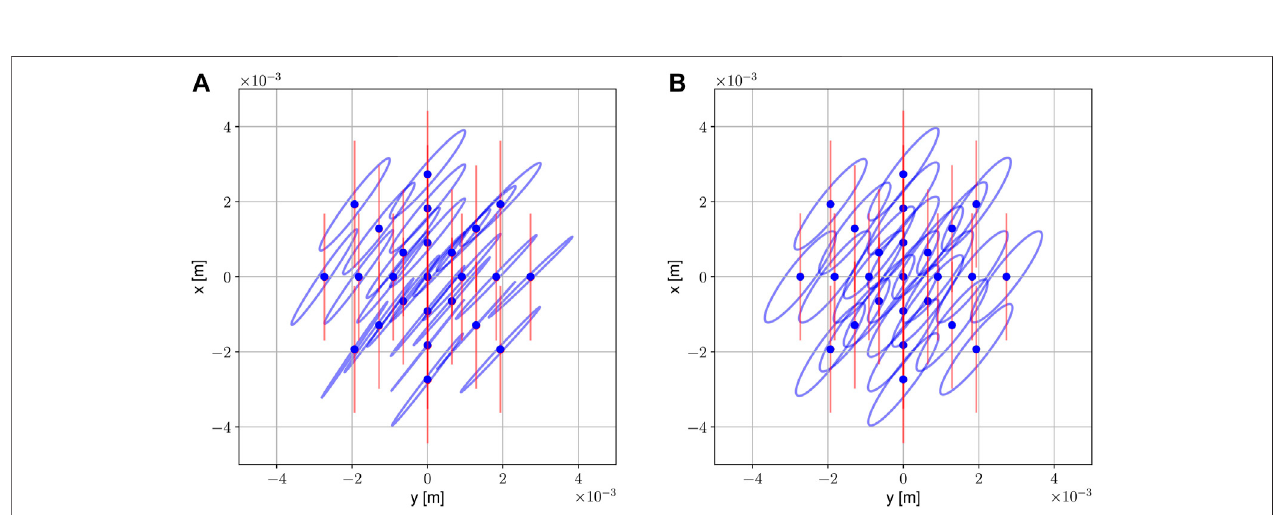
FIGURE 9 | Same as Figure 8 but with θ = 20 ° . The (A) graph shows the situation with c-axis inclination of 0.5 ° in the y - z -plane while the (B) is a reference for zero c-axis inclination.